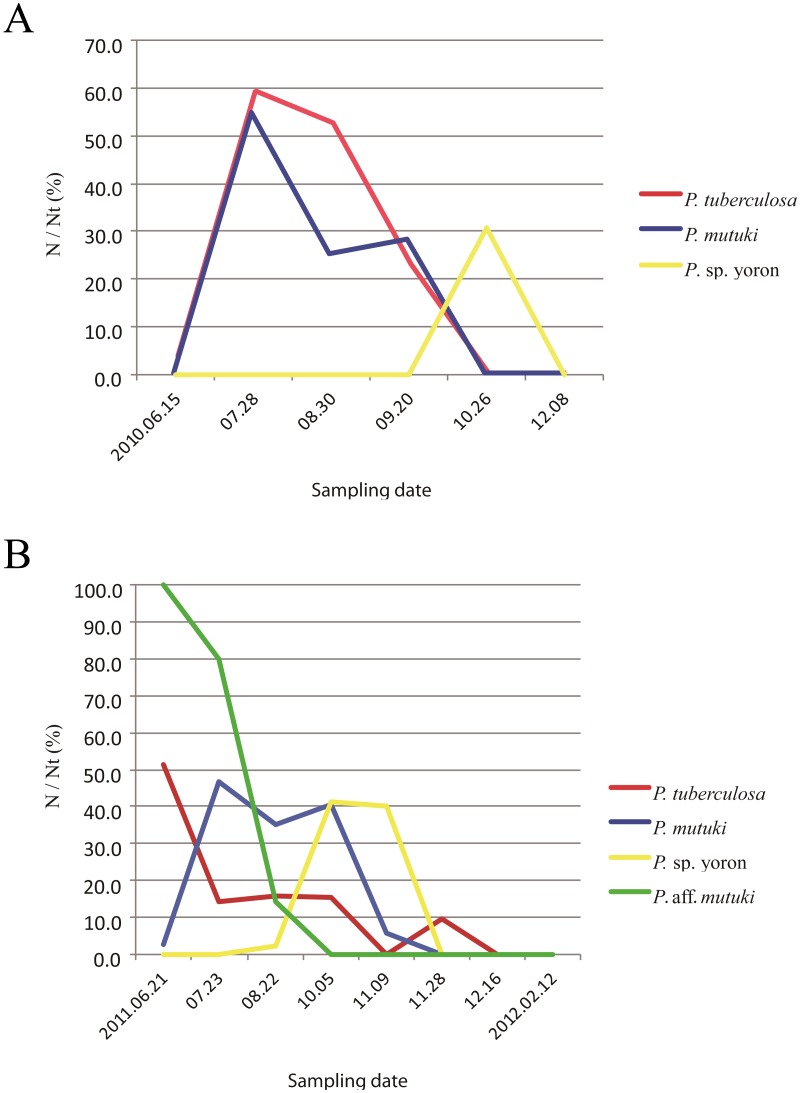
Monthly change of ratio of number of polyps possessing developing and/or developed ovaries (N) on total number of examined polyps (Nt).(A) Monthly change of ratio of number of polyps possessing developing and/or developed ovaries (N) on total number of examined polyps (Nt) in 2010. Red, P. tuberculosa; blue, P. mutuki; yellow, P. sp. yoron. (B) Monthly change of ratio of number of polyps possessing developing and/or developed ovaries (N) on total number of examined polyps (%) in 2011. Red, P. tuberculosa; blue, P. mutuki; yellow, P. sp. yoron; green, P. aff. mutuki.